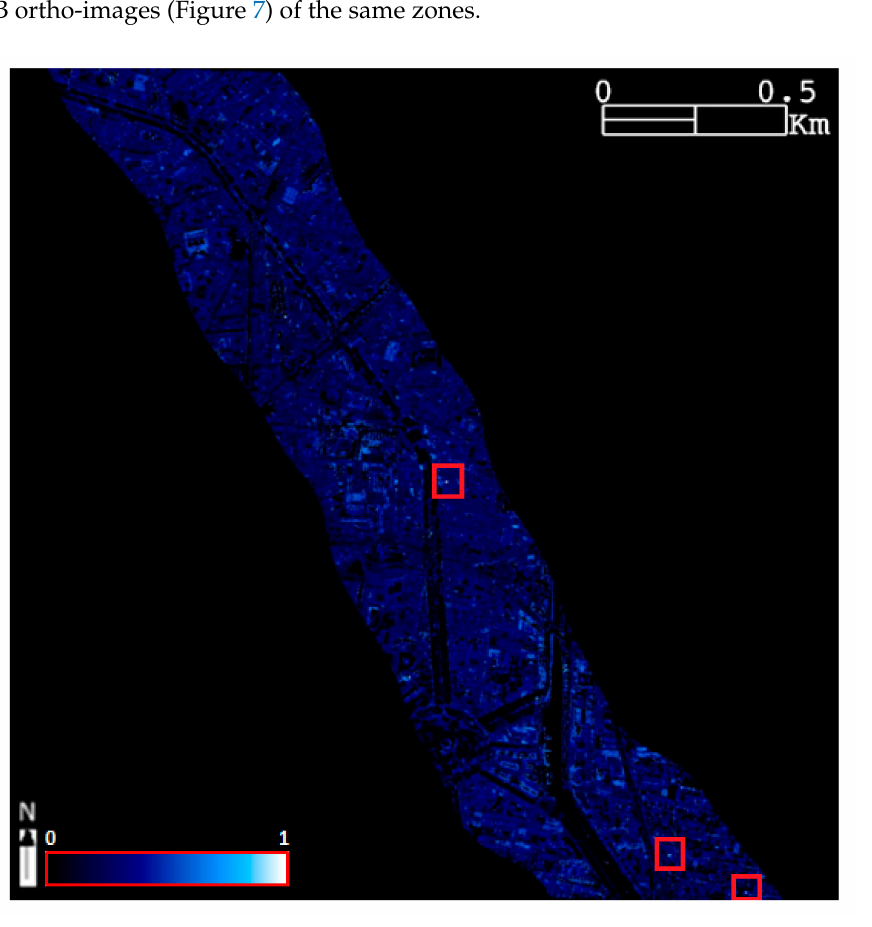
Figure 5. The obtained similarity map (based on the | CC | ) of the considered full hyperspectral image. Red rectangles surround potential zones (with pixels having high | CC |